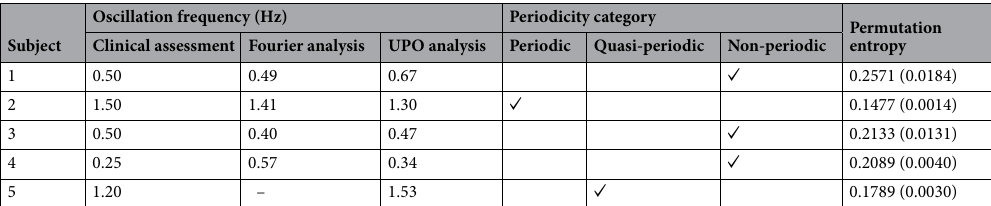
Table 2. Summary of the linear and nonlinear analyses of the nystagmus waveforms from each subject. Frequencies in Hz were calculated in three ways: (i) through approximation from chart recordings by experienced clinicians; (ii) through Fourier analysis (the reported frequency corresponds to the peak in the corresponding Fourier spectrum); (iii) from the dominant unstable periodic orbit (UPO). Periodicity categories were based on the attractor reconstructions shown in Fig. 6. Median permutation entropy values are given, with median absolute deviations in